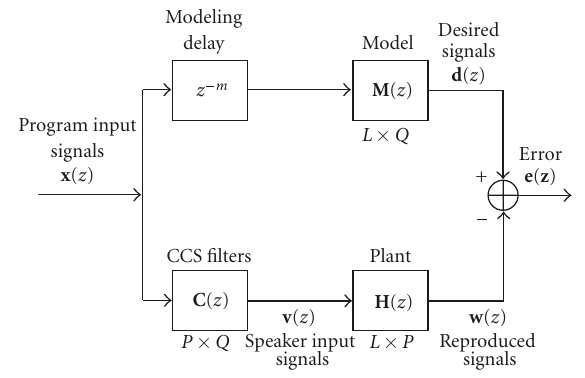
Figure 1: The block diagram of a multichannel model-matching problem in the CCS